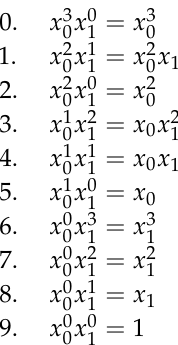
Figure 2a. The order of the elements in θ (cid:48)